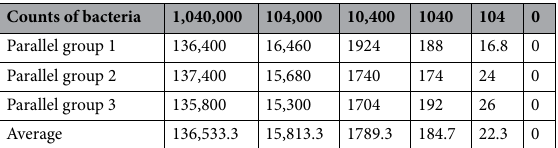
Table 5. Detecting E. coli ATCC25922 nucleic acid extracted from the simulated bacteremia blood sample.